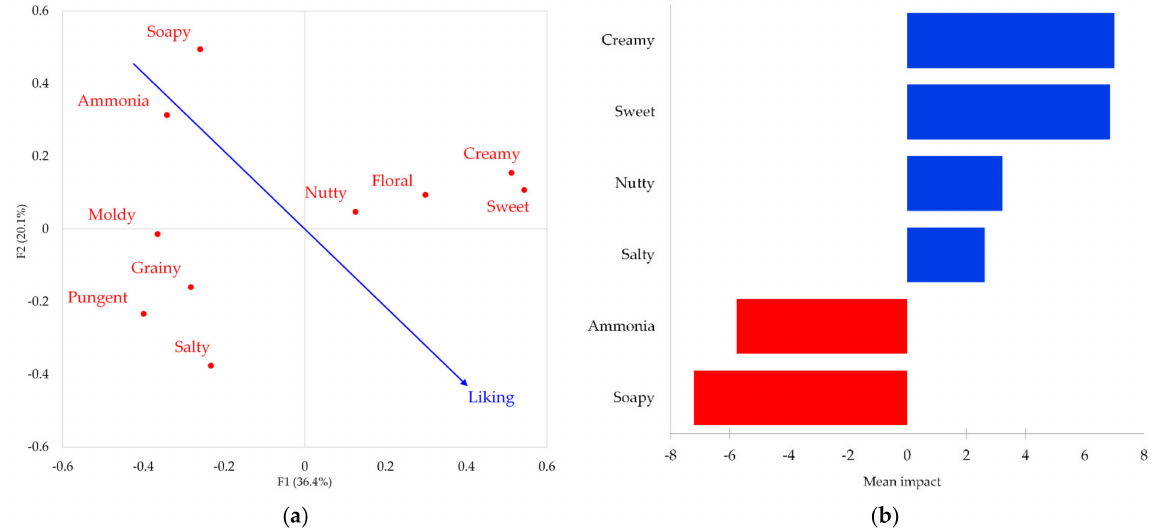
Figure 2. Results from the Penalty Analysis applied to the liking data and the occurrences obtained from the RATA test of the sensory attributes that resulted as being significant from the multiple pairwise comparison tests (Sheskin): ( a ) map from the Principal Coordinates Analysis (PCoA) applied to the correlation coefficient of the sensory attributes; ( b ) sensory attributes with a significant mean impact on liking (mean increases are displayed in blue while mean decreases are displayed in